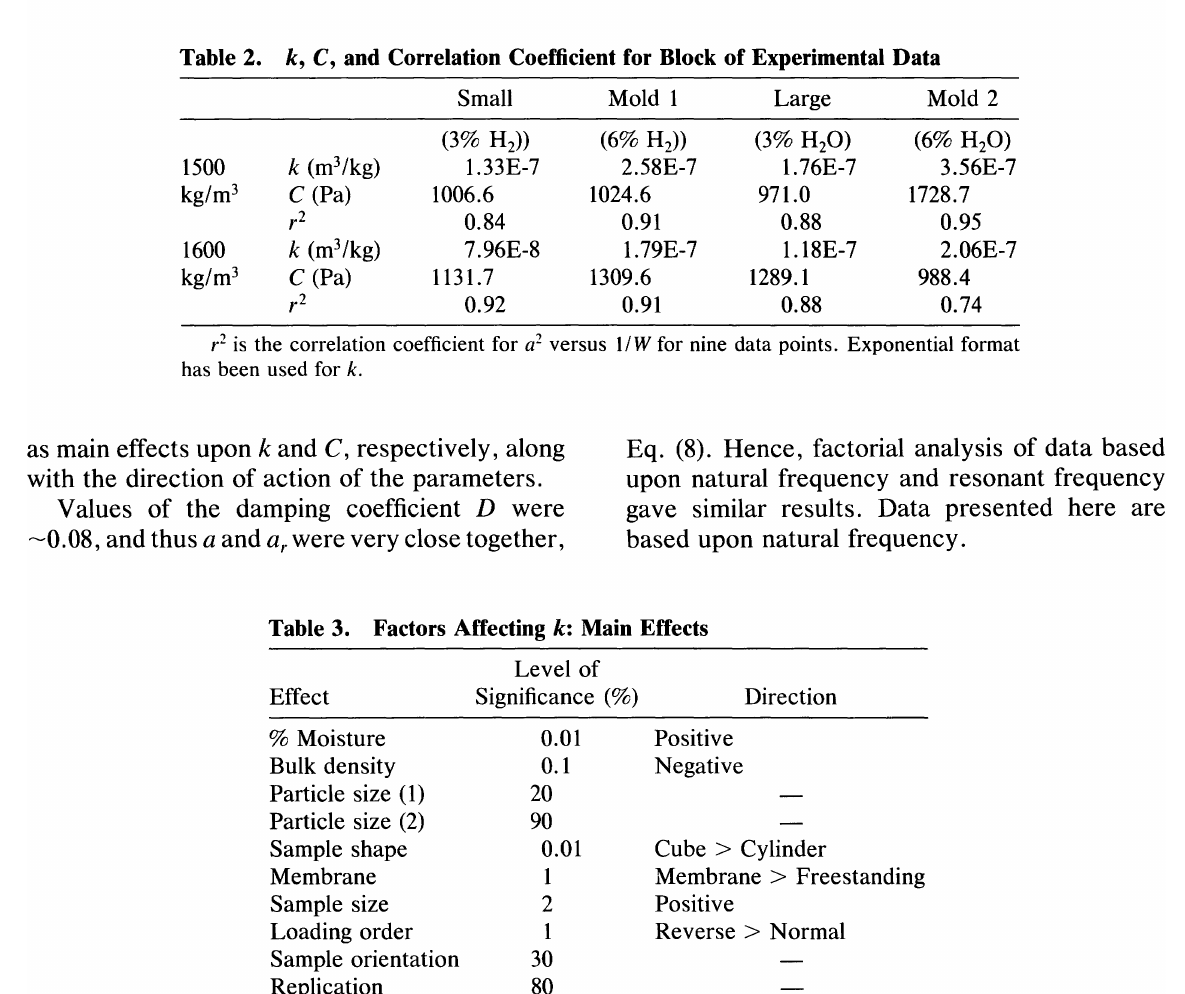
FIGURE 4 a 2 versus I!W for sample as in Fig. 3. Table 2. k, C, and Correlation Coefficient for Block of Experimental Data